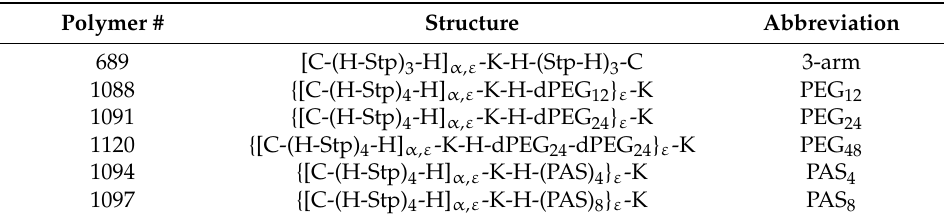
Table 1. List of oligomers included in this study. Internal polymer numbers, structures from N to C terminus, as well as abbreviations used within the